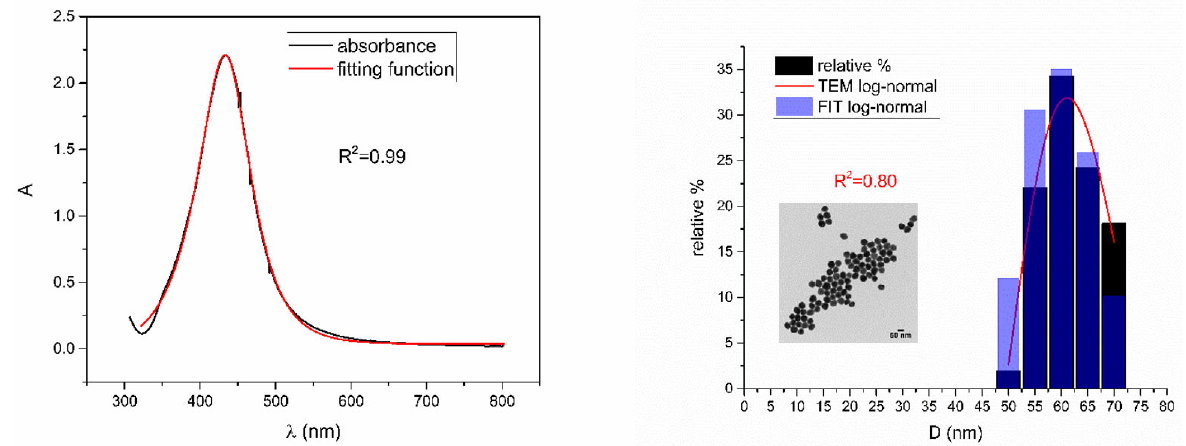
Figure 6. UV-Vis spectrum with fitting function ( left ) for sample NanoX_6. Reported and recon- structed size distributions are shown on the right . An additional TEM image is also shown.